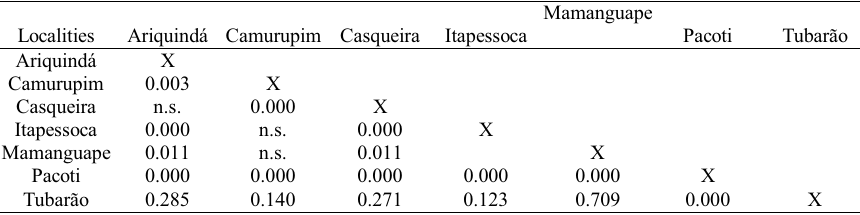
Table 4. Results of the post-hoc Mann-Whitney test (with the p values adjusted by the Bonferroni’s correction) performed on the heights of female specimens of Hippocampus reidi recorded at seven Brazilian localities.